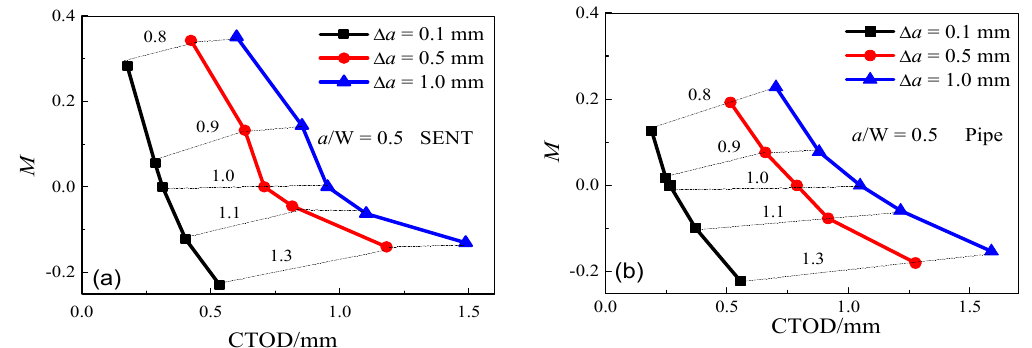
Figure 12. M versus CTOD for the mismatched specimens ( a ) SENT; ( b ) pipe.